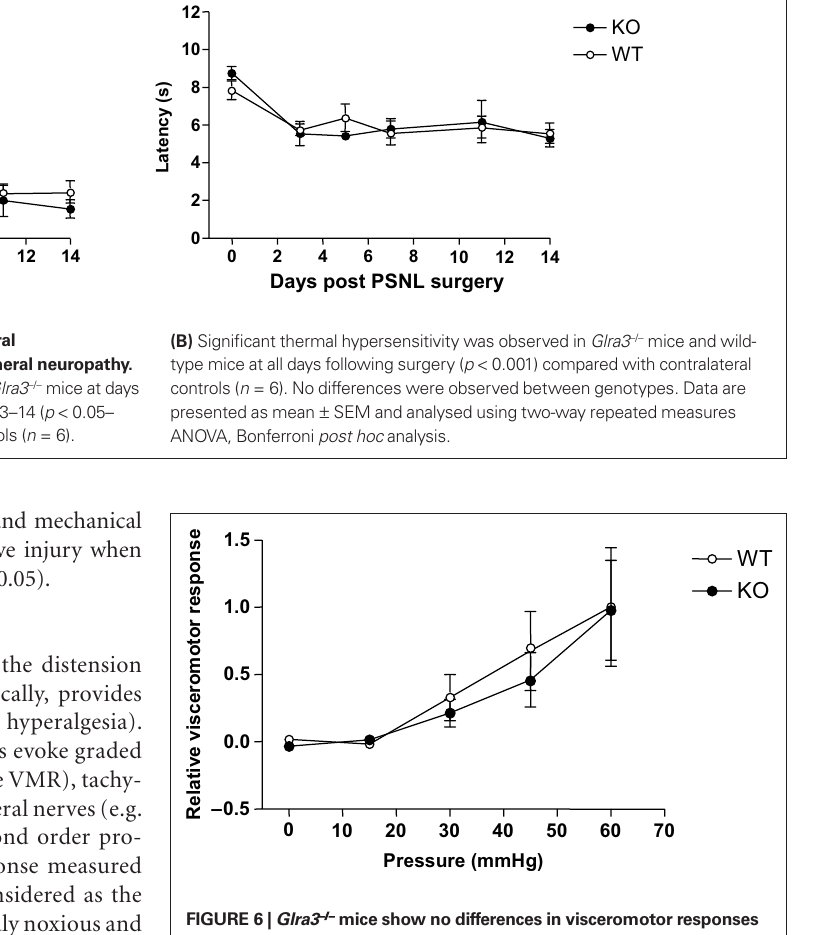
FIGURE 6 | Glra3 − / − mice show no differences in visceromotor responses to colorectal distension. Isofl urane anesthetised mice display graded visceromotor responses to increasing colorectal pressures. No differences were observed between genotypes ( Glra3 − / − , n = 5; wild type, n = 7). Data are presented as mean (normalised to maximum wild-type control) ± SEM.